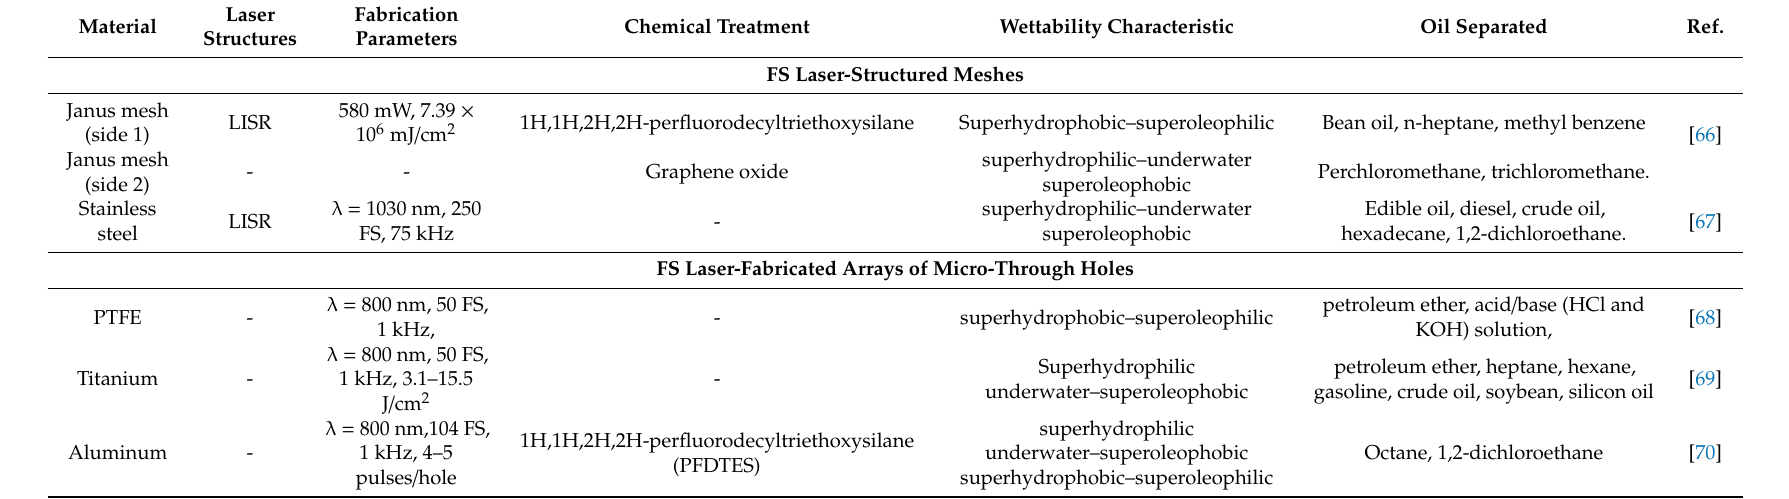
Table 1. Oil–water separation filters / meshes realized by FS laser